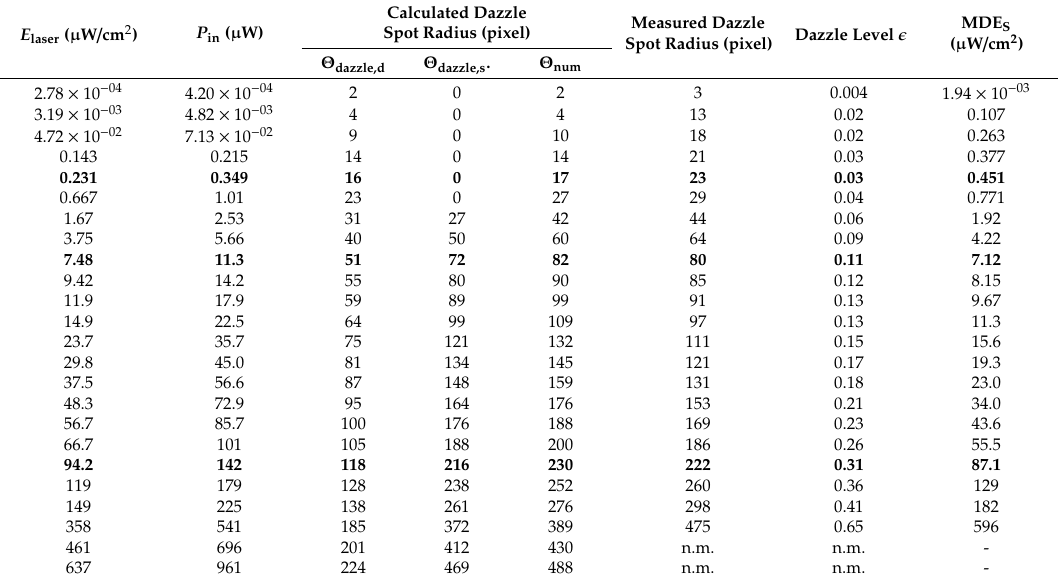
Table 7. Calculated and measured dazzle spot size using Setup 2 for a laser wavelength of 488 nm. Abbreviation: n.m.: not measurable.